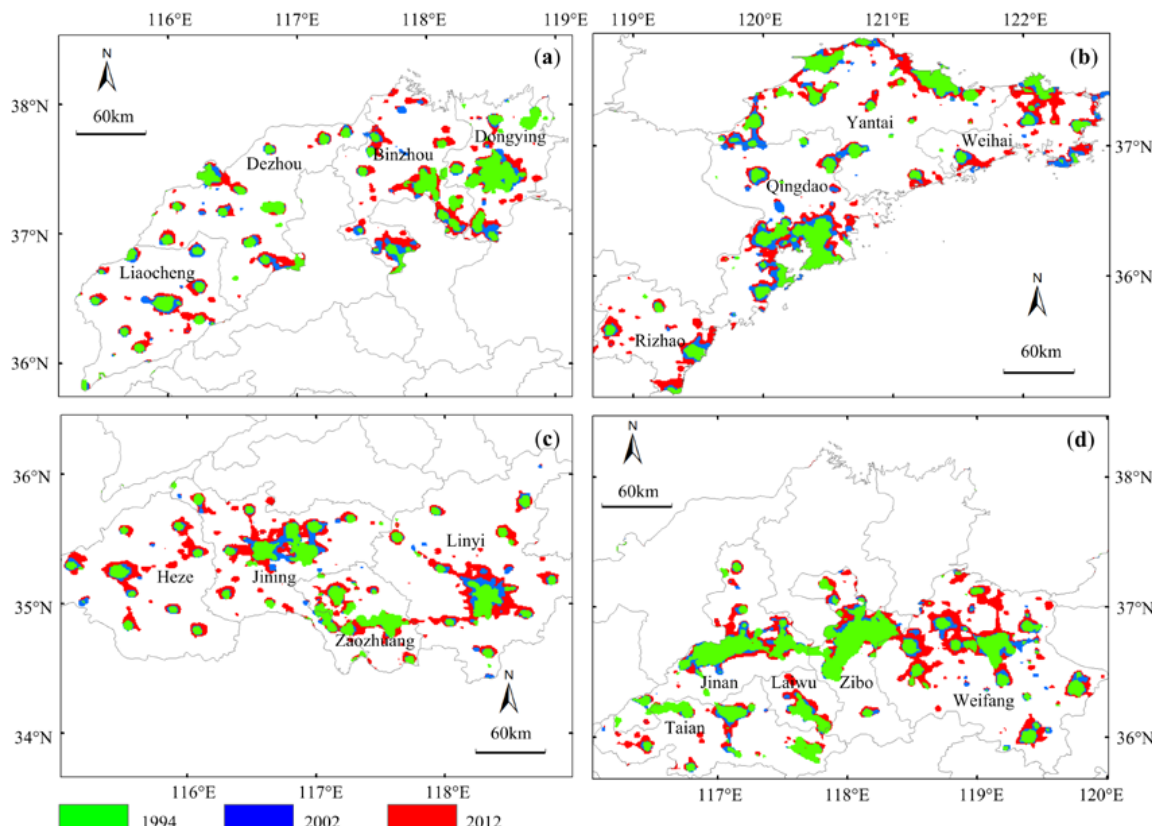
Figure 4. The urban areas of Shandong province in1994 (green), 2002 (blue), 2012(red): (a) the eastern coastal region; (b) the middle region; (c) the northern region; (d) the southern